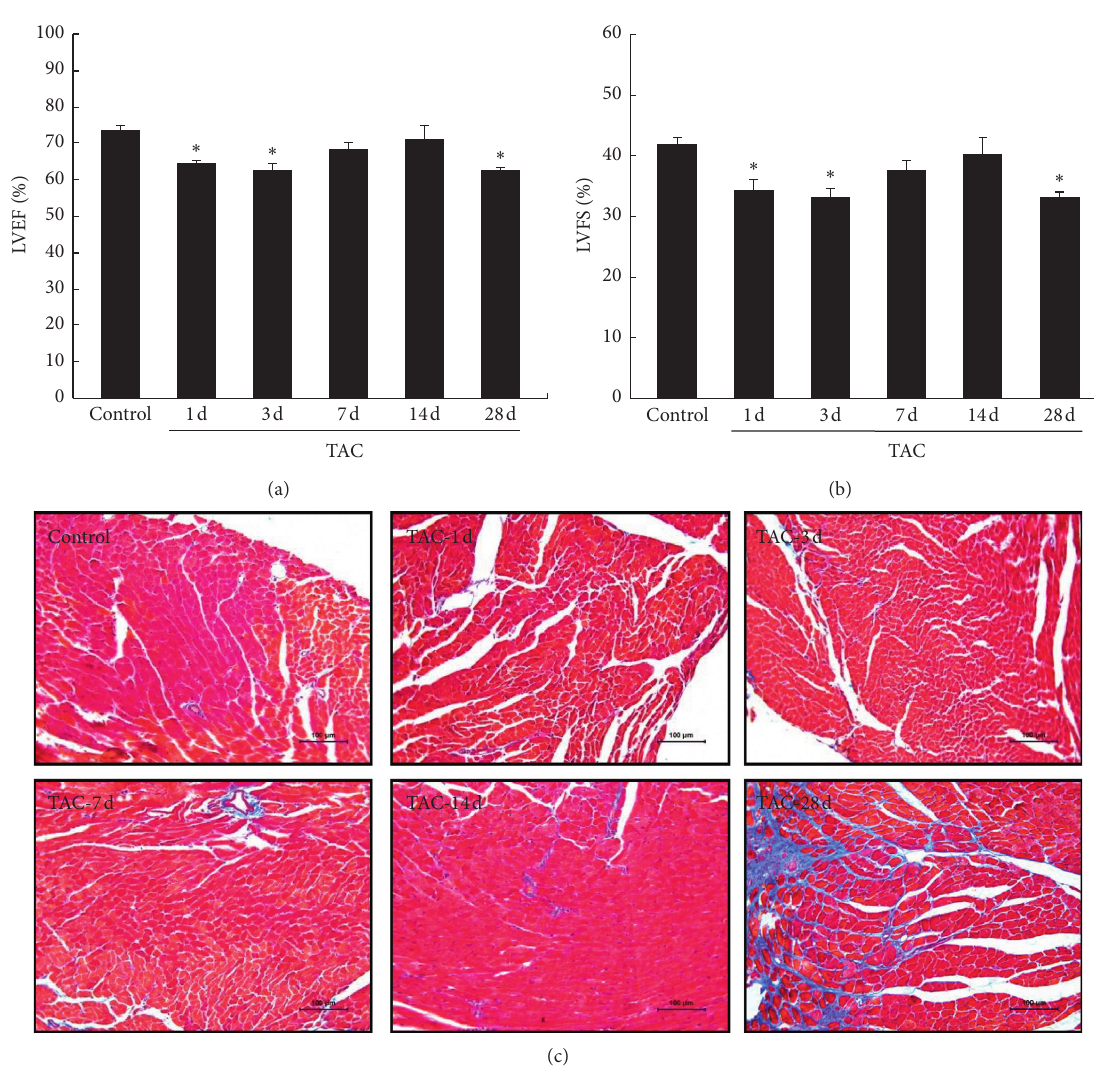
Figure 2: Echocardiography measurement and Masson staining in mice within 4 weeks after TAC measurement of LV ejection fraction (LVEF) and LV fractional shortening (LVFS). (c) Representative images of the whole hearts after TAC (scale bars 100 μ m). Values are expressed as mean ± S.E.M. n > 8 per group in each group. ∗ P < 0 . 01 versus